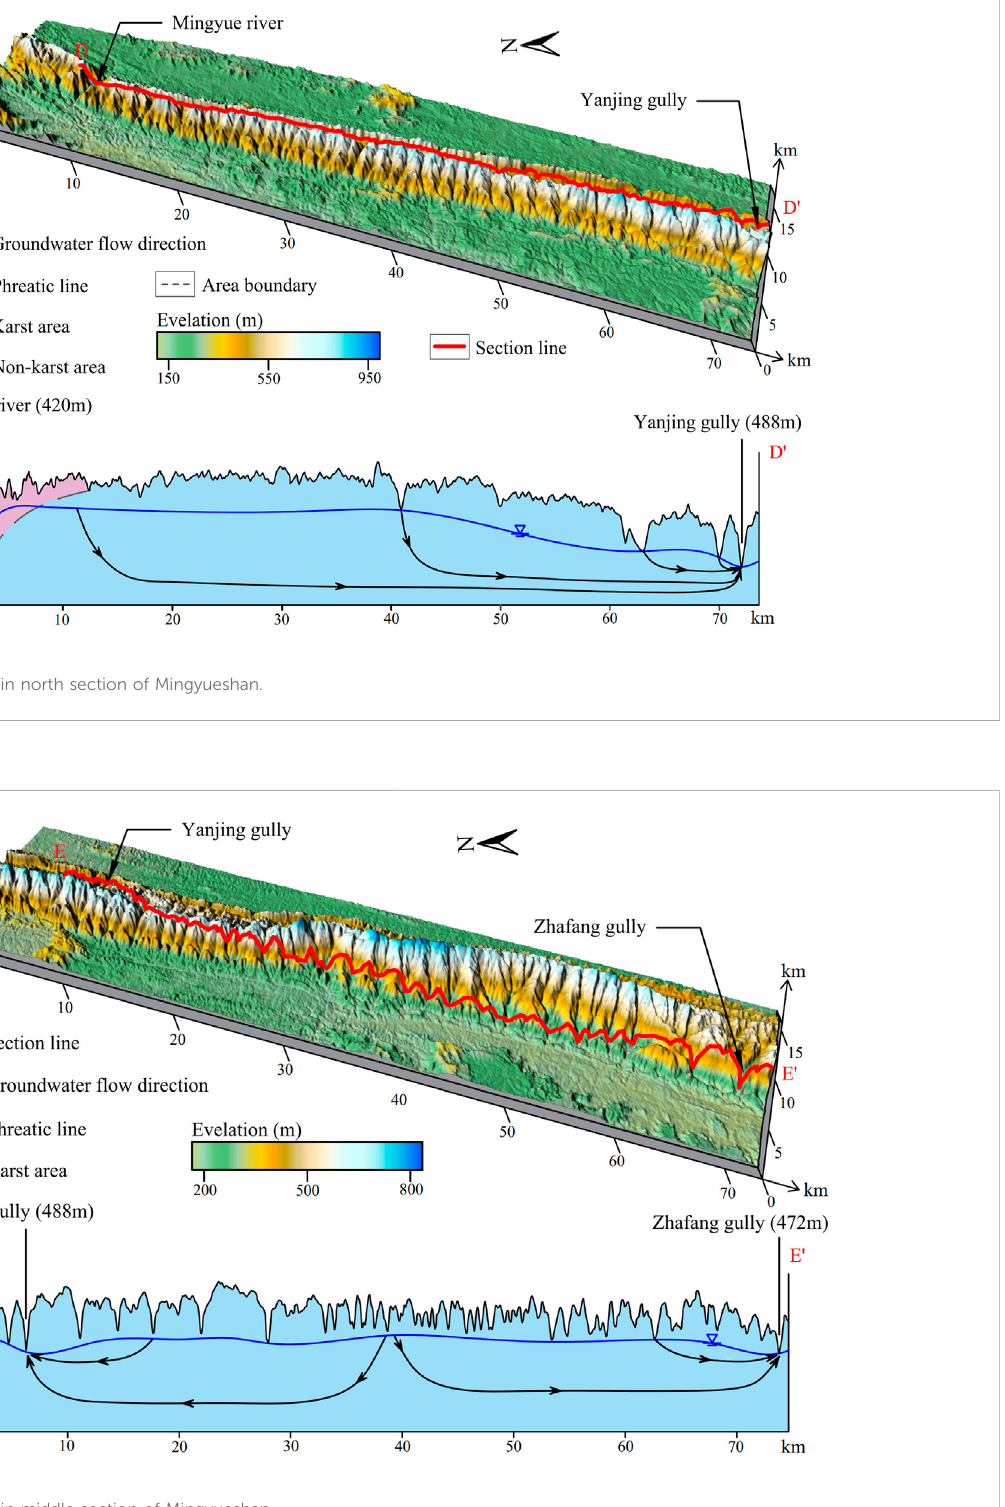
merges with each other, leading to the increasing difference in the depth and shallow degree of the transverse gully development. In the development of a series of shallow transverse gullies, a deep cutting